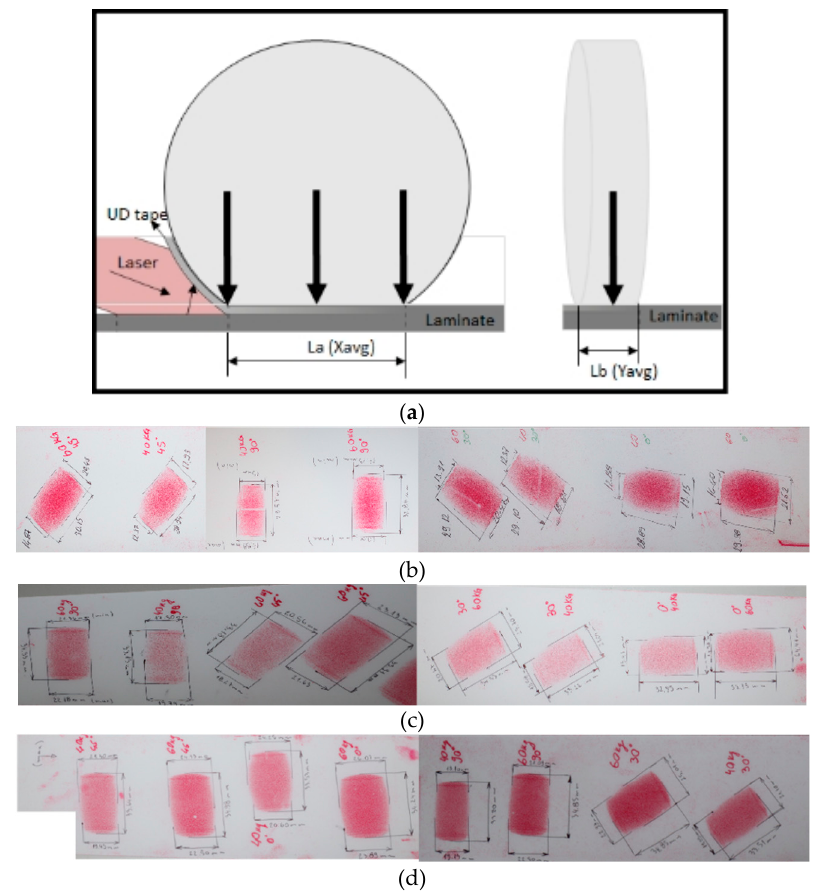
Figure 3. Compaction pressure distribution measurement experiment—color density distribution on the pressure measurement film after the pressure; ( a ) contact between rollers and flat molds ( b ) around P1 and tilt angle 10 ◦ ; ( c ) around P2 and tilt angle 10 ◦ ; ( d ) around point P2 and tilt angle 13 ◦